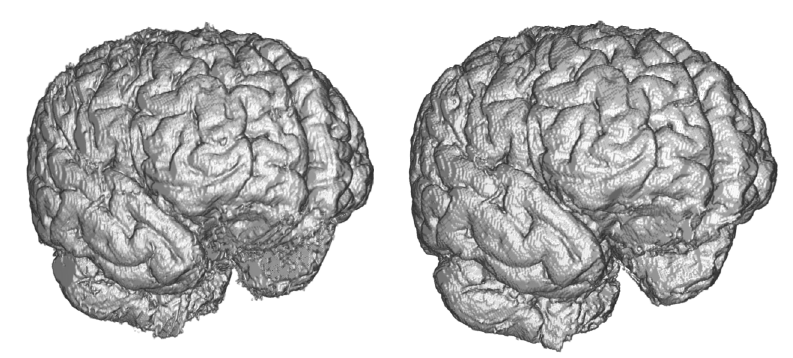
Figure 8. Comparison of ground truth brain model ( left ) and brain model segmented by Dense-U-Net ( right ) after the final phase of training.